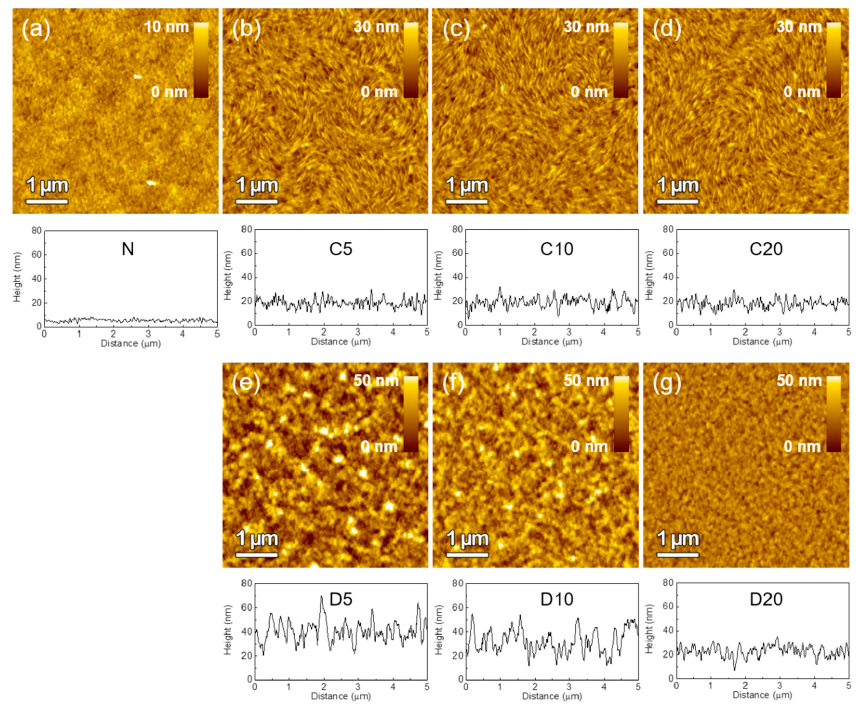
Figure 5. Atomic force microscopy images of the ordering agent (OA)-induced polymer surface morphology and height profile. PCPDTBT ( a ) without OA; ( b ) with 5 vol % 1-chloronaphthalene (CN); ( c ) with 10 vol % CN; ( d ) with 20 vol % CN; ( e ) with 5 vol % 1,8-diiodooctane (DIO); ( f ) with 10 vol % DIO; and ( g ) with 20 vol % DIO.